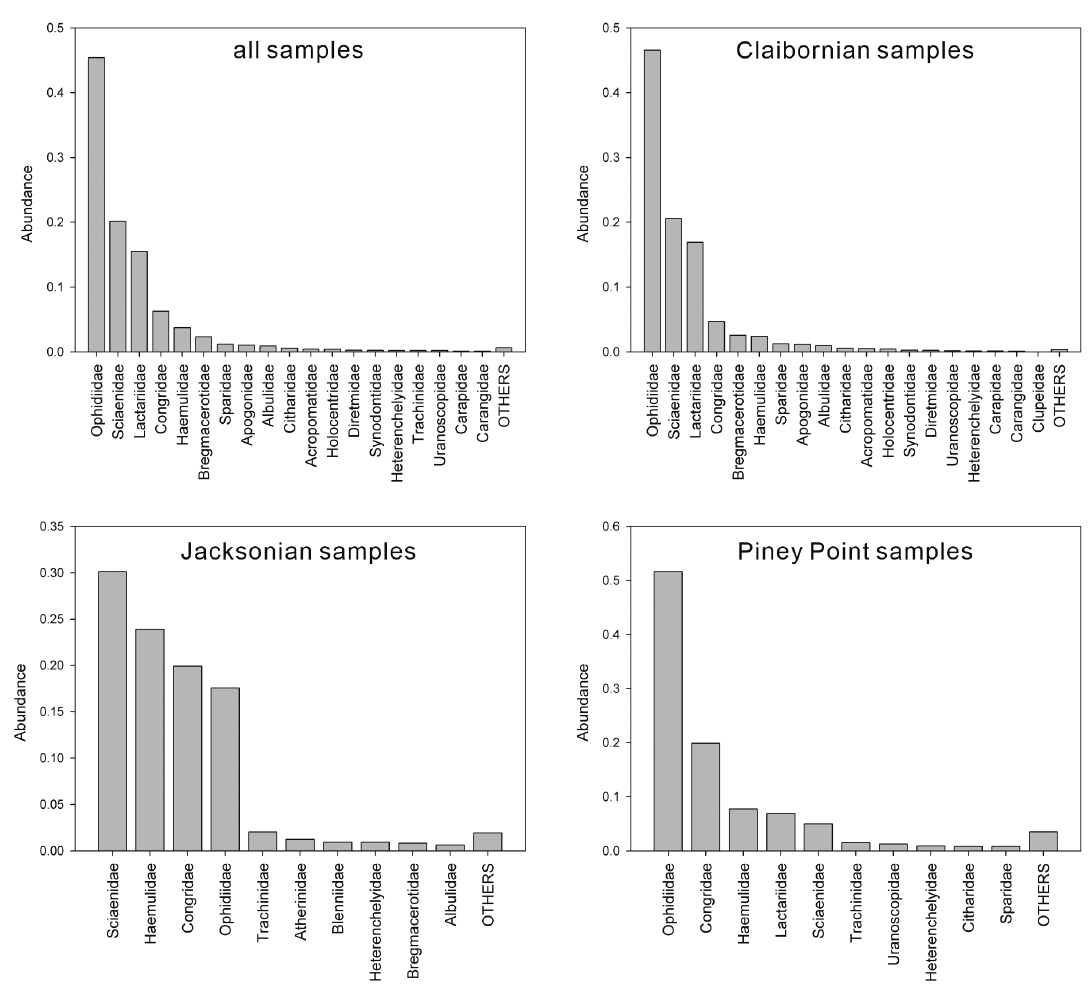
Fig. 40. Rank-abundance of fish families from the middle and late Eocene of the eastern and southern USA otolith assemblages. Previous studies are not included